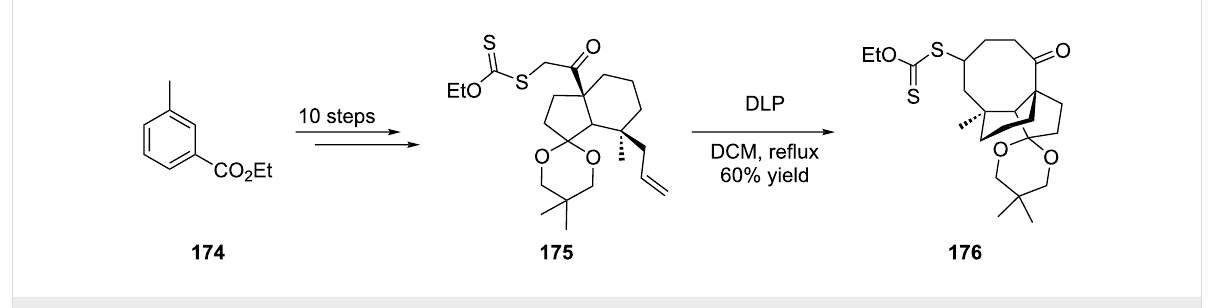
Belonging to the fusicoccane diterpenoid family, hypoestin A ( 177 ) (Figure 5) can play an important role in cardiovascular and neurological diseases by its inhibitory activity of the Ca v 3.1 calcium channel. From a chemical point of view, hypoestin